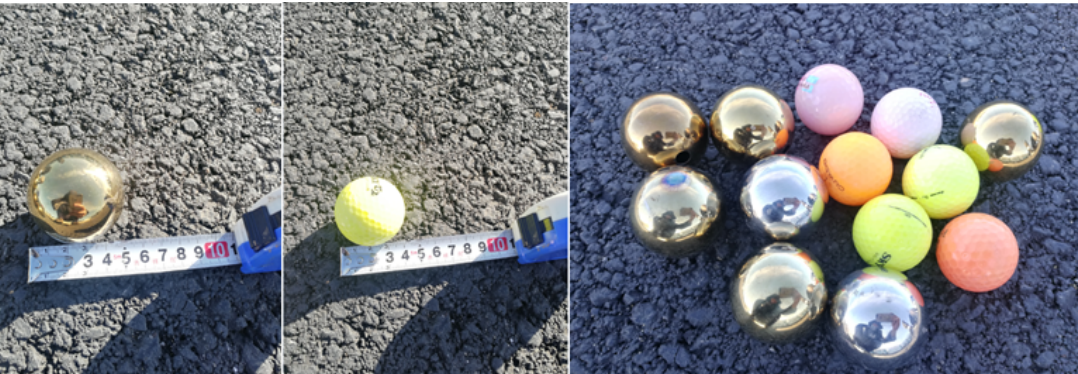
Figure 7. FOD targets used in the